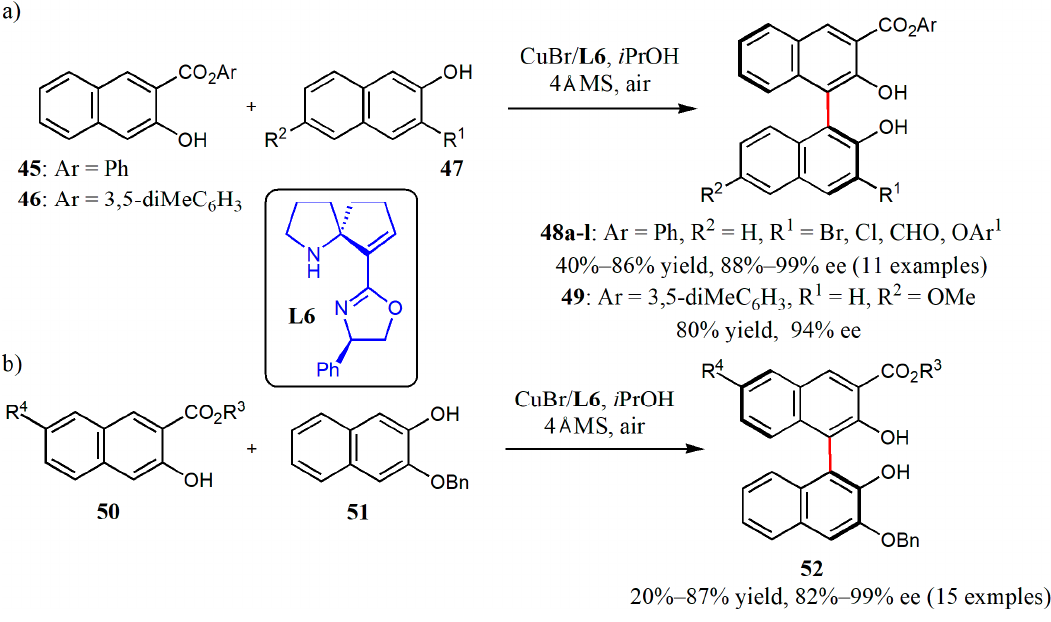
Figure 15. Enantioselective synthesis of 3,3’-substituted C1-symmetric BINOLs by Cu-catalyzed CDC.